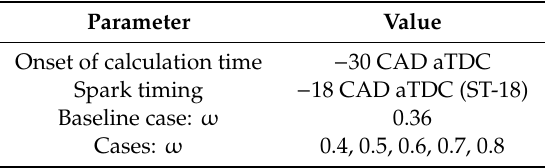
Table 2. Operating Table 2. Operating parameters.